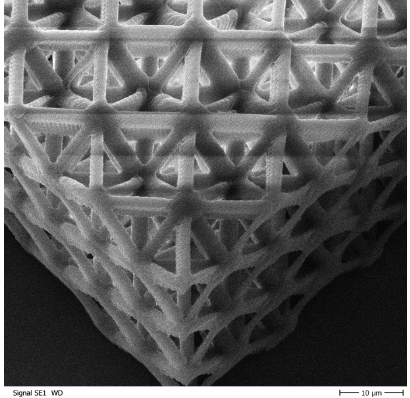
Figure 19. Dimension scale: octet structure (16 microns element size)